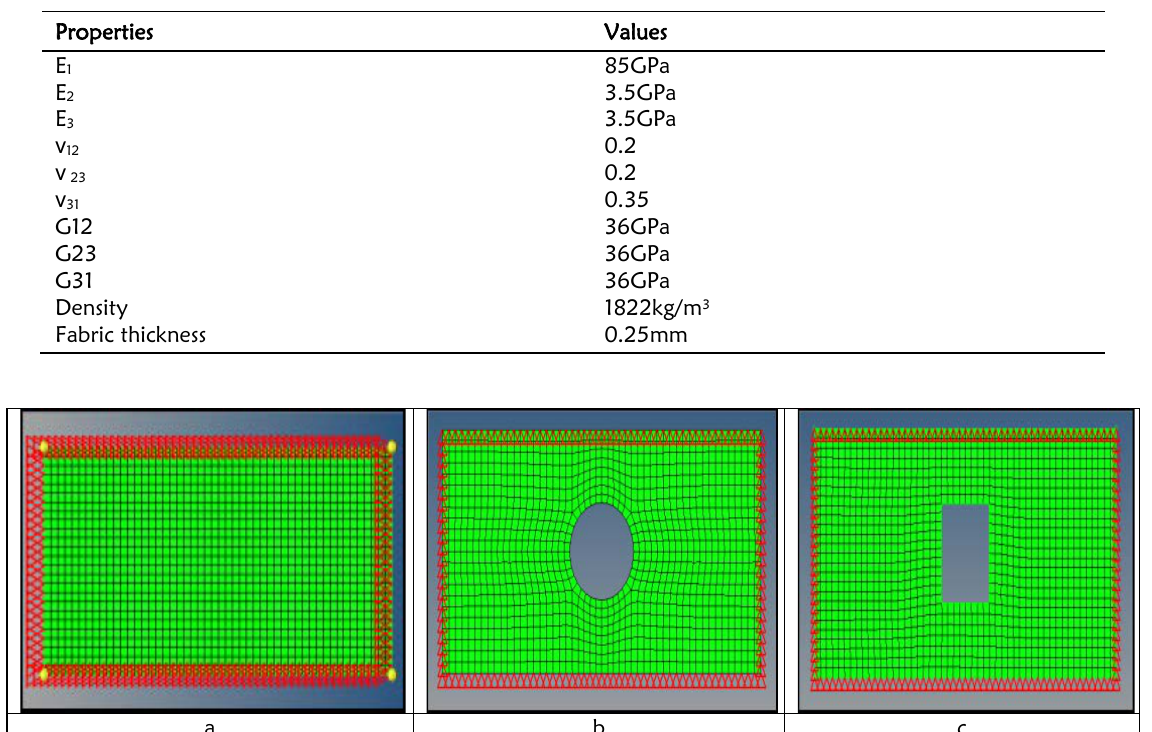
Figure 4: Plate with circular hole (CCCF condition) Table 1: Properties of S Glass Bidirectional fabric